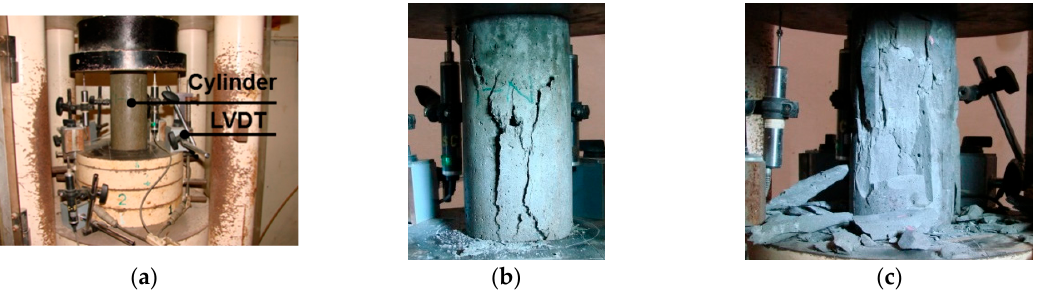
Figure 3. Compressive strength test of the cylinder: ( a ) Test setup; ( b ) columnar cracking (NWM); ( c ) columnar cracking (LWM).